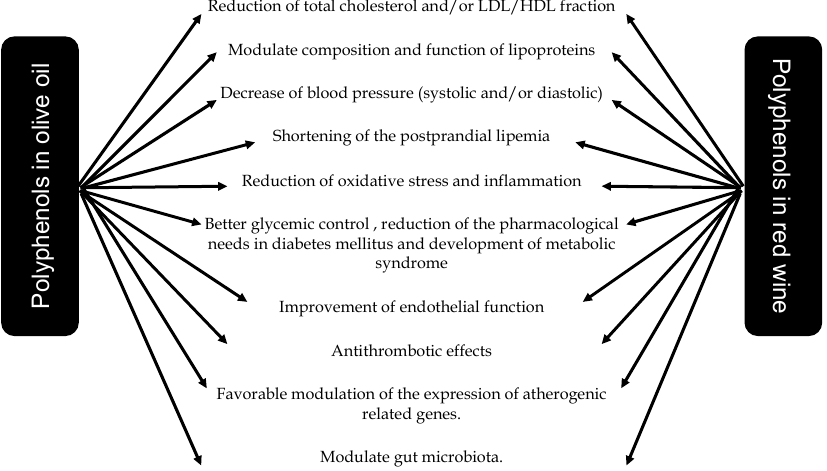
Figure 4. Impact of polyphenol content in moderate consumption of wine and olive oil on cardiovascular disease prevention and management.